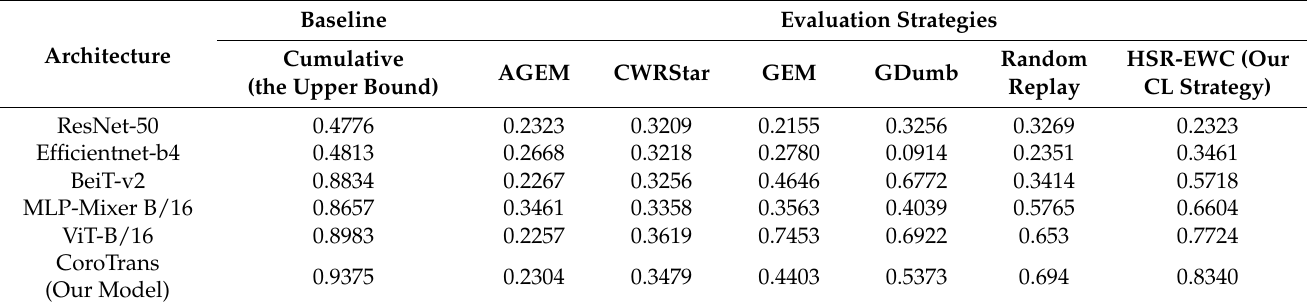
Table 4. A comparison of the average accuracy of different strategies.